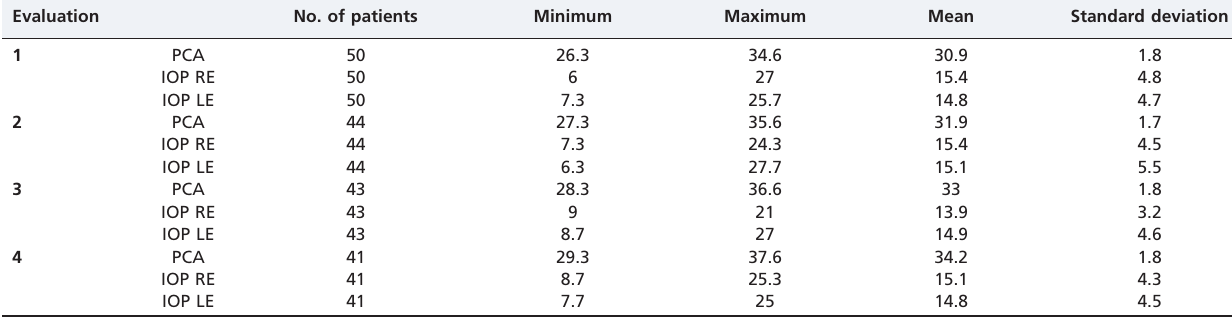
Table 1 - Descriptive analysis of the